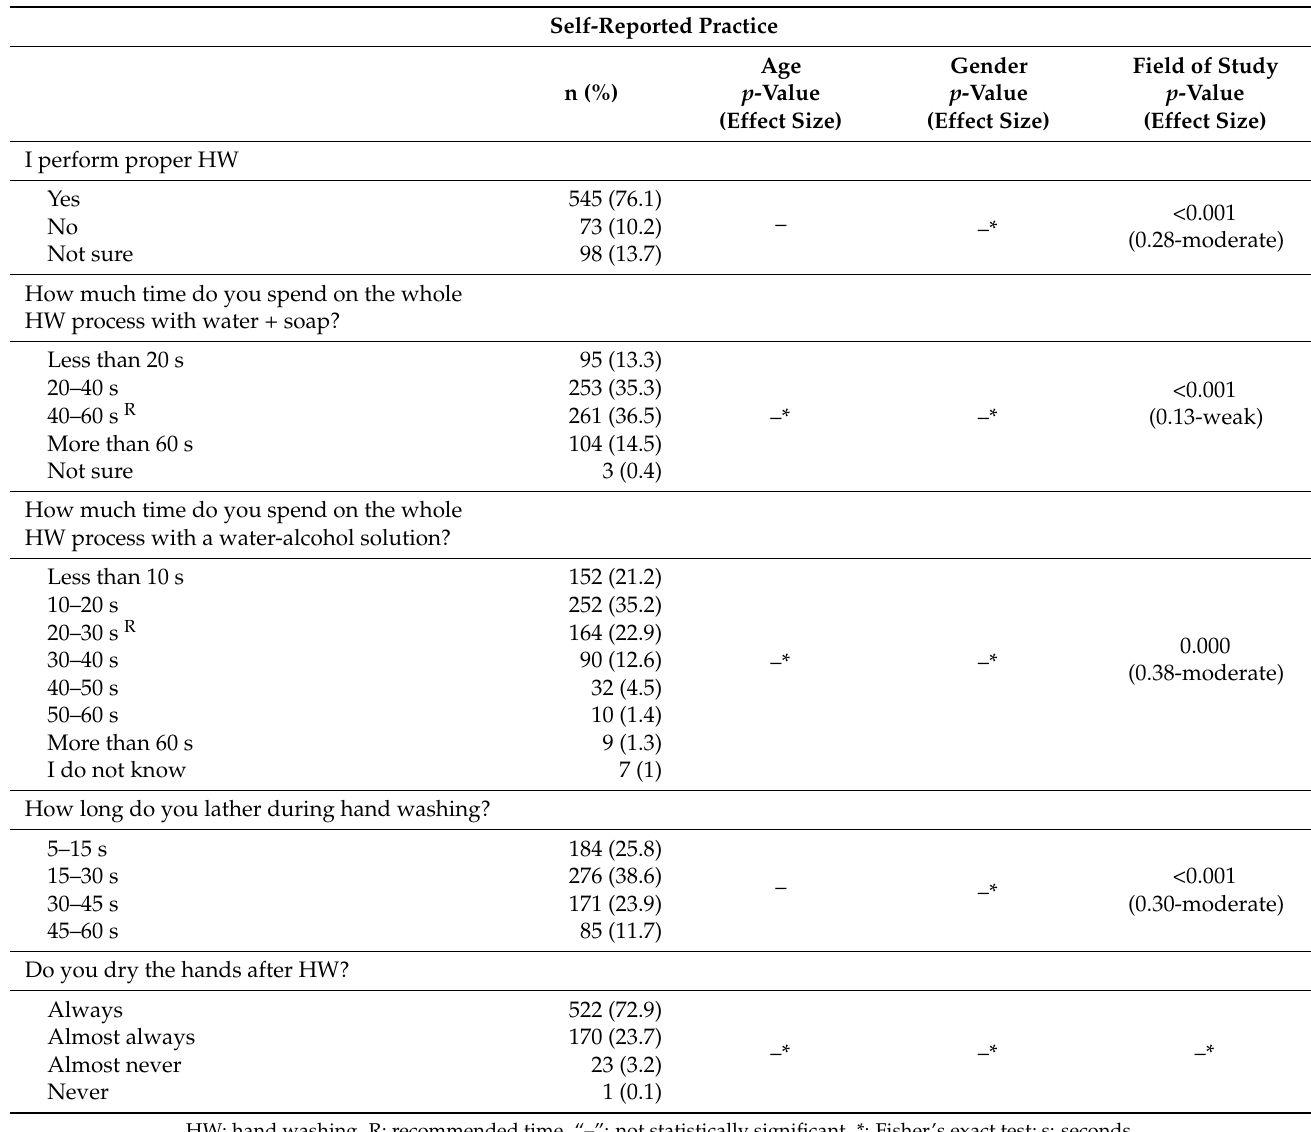
Table 6. Practices self-reported by the participants in relation to hand